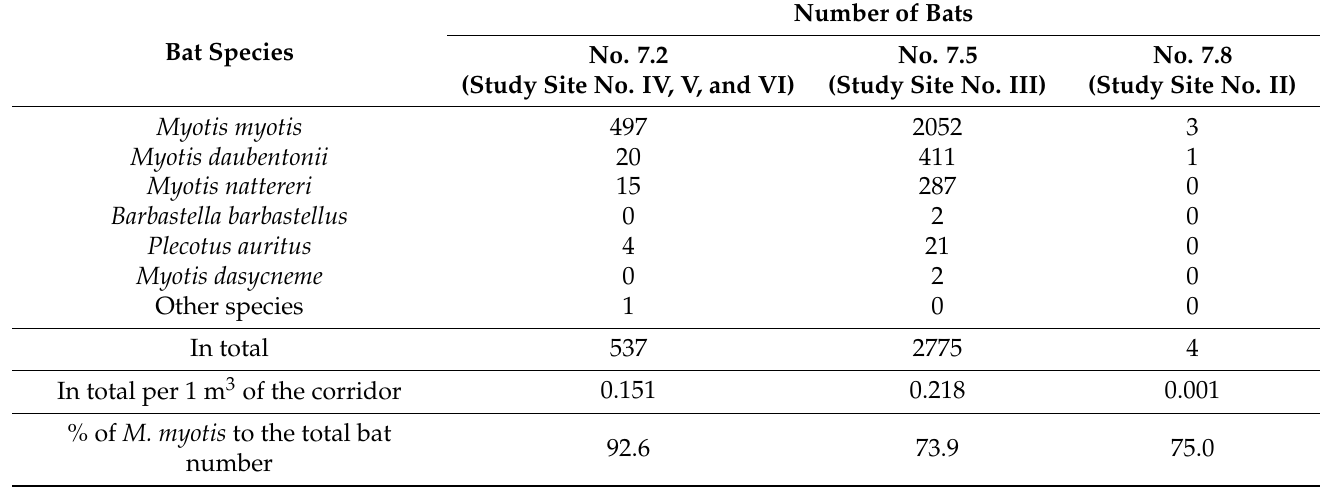
Table 2. The number and species composition of the bats found in parts of the Nietoperek bat reserve underground investigated for